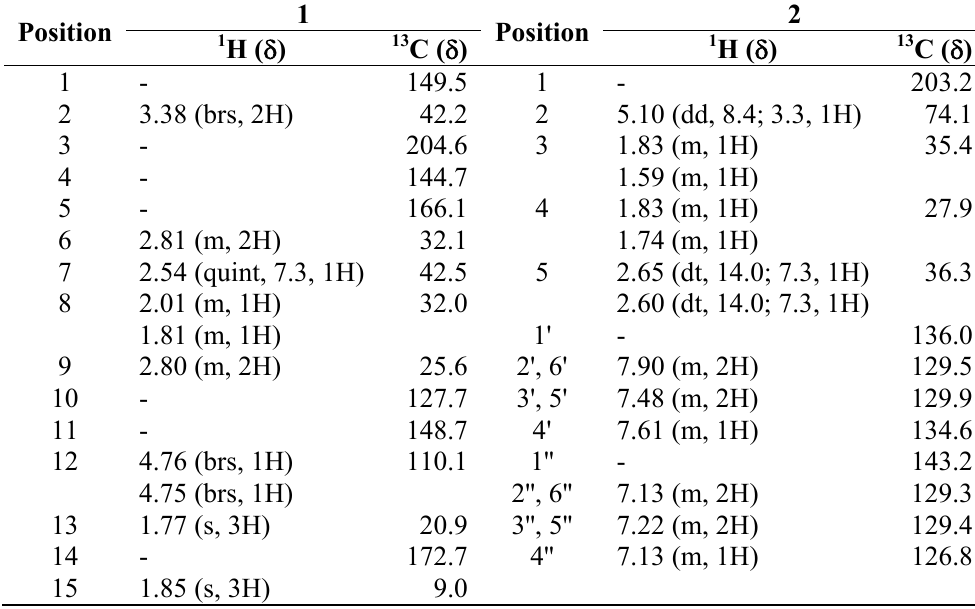
Table 1. 1 H-NMR (500 MHz,) and 13 C-NMR (125 MHz,) data of oleodaphnoic acid ( 1 ) (CDCl ) and coriaceol ( 2 ) (CD 3